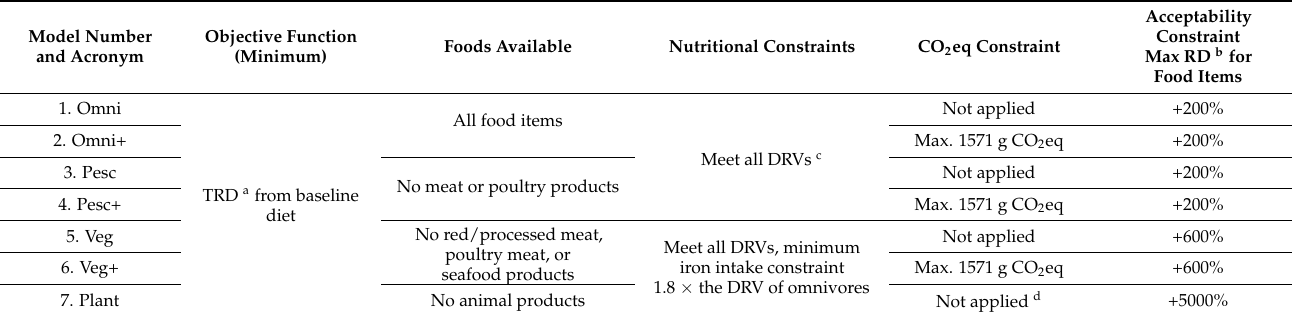
Table 1. Names and characteristics of all applied models.